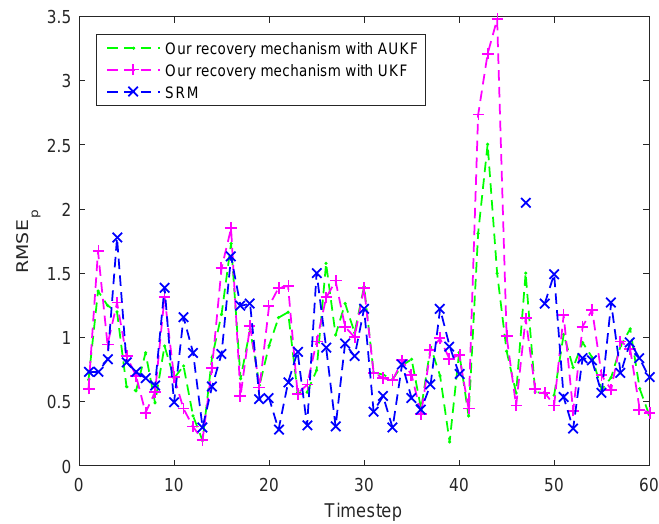
Figure 15. Tracking errors ( RMSE p ) at each timestep under different recovery mechanism when the target enters a coverage hole.